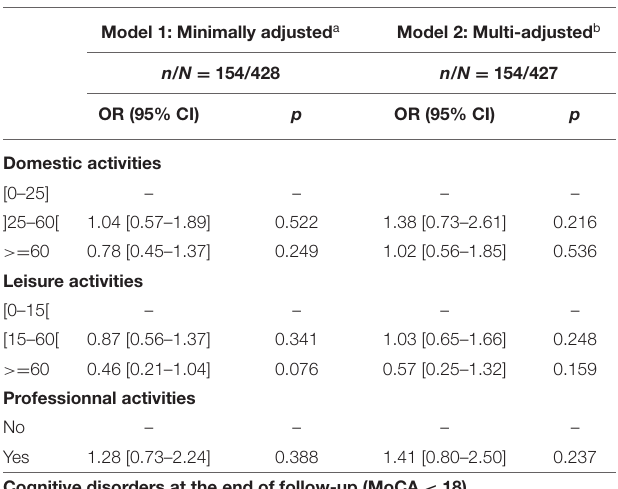
TABLE 2 | Association between baseline physical activity and risk of cognitive disorders. Cognitive disorders at the end of follow-up (MoCA < 27) Model 1: Minimally adjusted